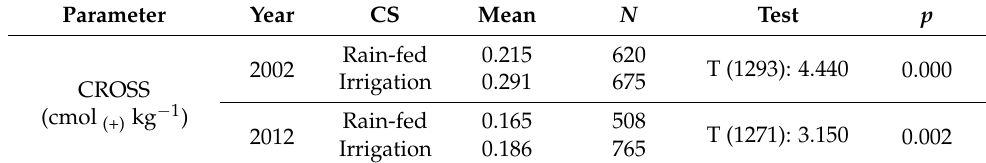
Table 6. CROSS evolution when comparing rain-fed and irrigation sites from 2002 to 2012. Parameter Year CS Mean N Test p Rain-fed 0.215 620 2002 CROSS (cmol (+) kg − 1 )